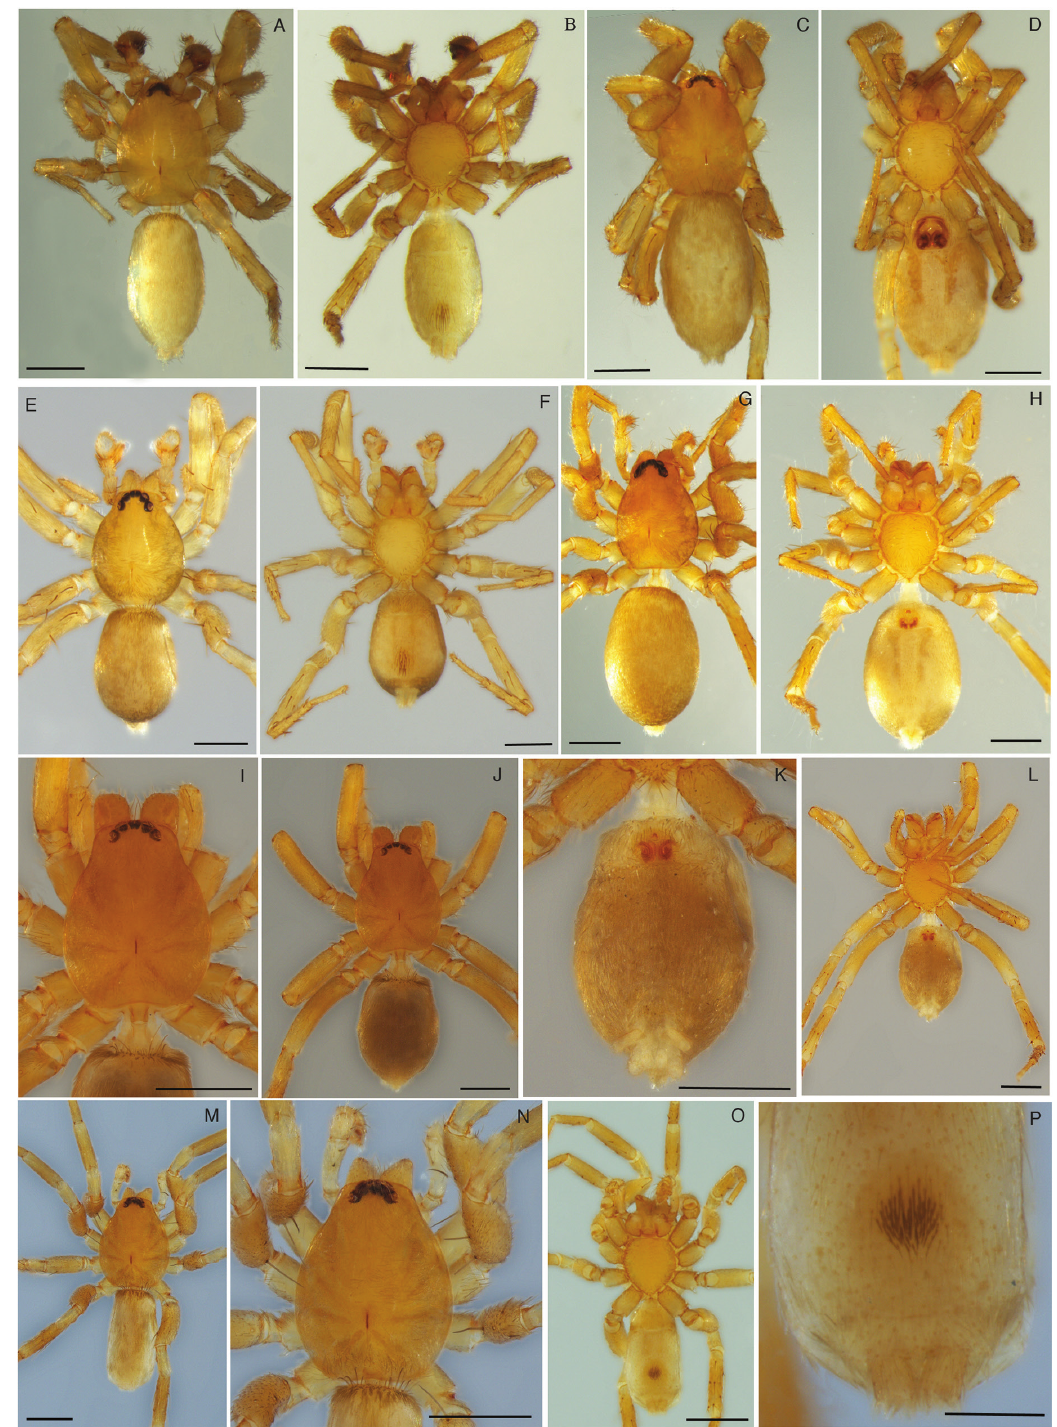
Fig. 2. A-D. Cteniogaster conviva sp. nov. A. ♂, habitus dorsal view. B. Idem, ventral view. C. ♀, habitus, dorsal view. D. Idem, ventral view. E-H. Cteniogaster toxarchus gen. et sp. nov. E. ♂, habitus dorsal view. F. Idem, ventral view. G. ♀, habitus, dorsal view. H. Idem, ventral view. I-P. Cteniogaster hexomma sp. nov. I. ♀, prosoma, dorsal view. J. Idem, habitus, dorsal view. K. Idem, abdomen, ventral view. L. Idem, habitus, ventral view. M. Idem, ♂, habitus, dorsal view. N. Idem, prosoma, dorsal view. O. Idem, habitus, ventral view. P. Idem, abdomen, ventral view. Scale bars: A-O = 0.5 mm; P = 0.2